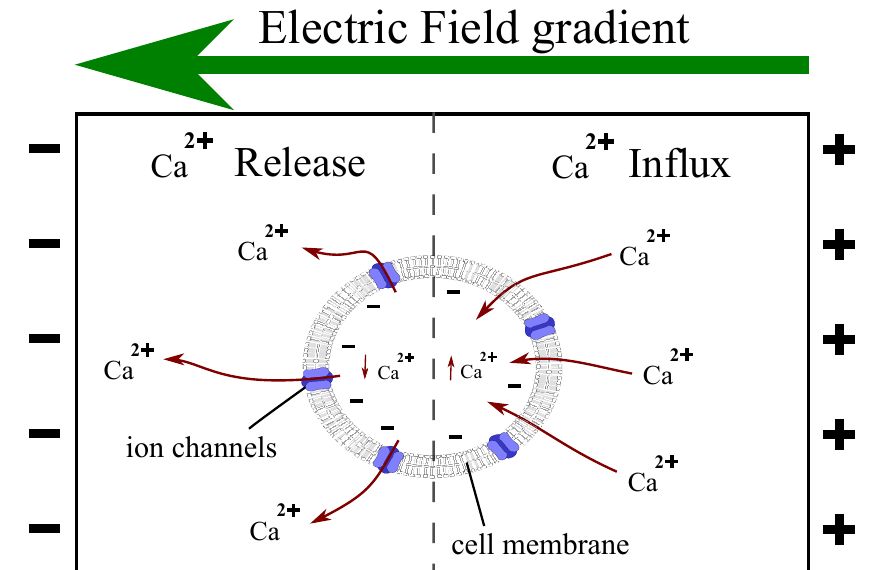
Figure 2. Cell electrotaxis. Cell membrane towards the anode is hyperpolarized allowing the influx of Ca 2 + by passive electromechanical diffusion. In the cathodic side, the cell is depolarized, and its ion channels open releasing Ca 2 + . The net electrotactic force depends on the balance of the two opposing attraction